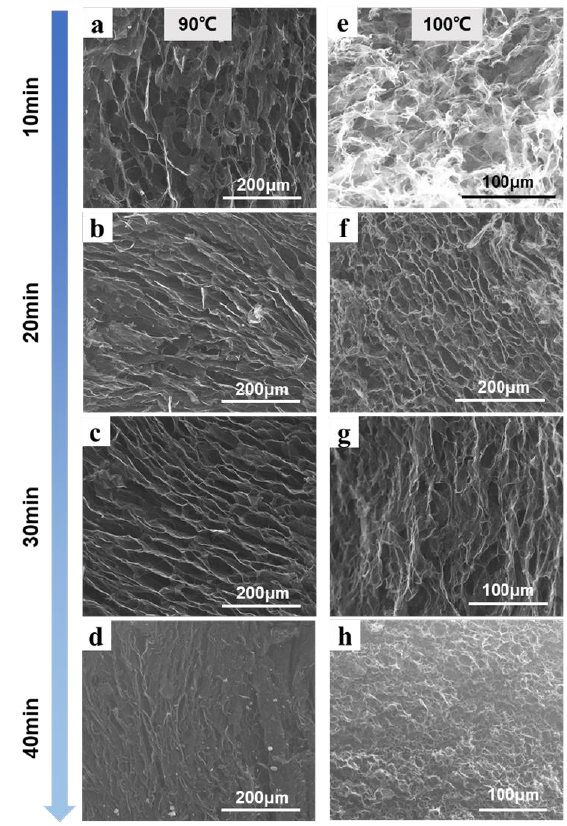
Figure 4. Effect of hydrothermal temperature and reduction time on the microstructure of graphene gel. ( a ) hydrothermal reduction at 90 °C for 10 min; ( b ) hydrothermal reduction at 90 °C for 20 min; gel. ( a ) hydrothermal reduction at 90 ◦ C for 10 min; ( b ) hydrothermal reduction at 90 ◦ C for 20 min; ( c ) hydrothermal reduction at 90 °C for 30 min; ( d ) hydrothermal reduction at 90 °C for 40 min; ( e ) ( c ) hydrothermal reduction at 90 ◦ C for 30 min; ( d ) hydrothermal reduction at 90 ◦ C for 40 min; hydrothermal reduction at 100 °C for 10 min;( f ) hydrothermal reduction at 100 °C for 20 min; ( g ) hydrothermal reduction at 100 °C for 30 min; ( h ) hydrothermal reduction at 100 °C for 40 min. ( e ) hydrothermal reduction at 100 ◦ C for 10 min;( f ) hydrothermal reduction at 100 ◦ C for 20 min; ( g ) hydrothermal reduction at 100 ◦ C for 30 min; ( h ) hydrothermal reduction at 100 ◦ C for 40